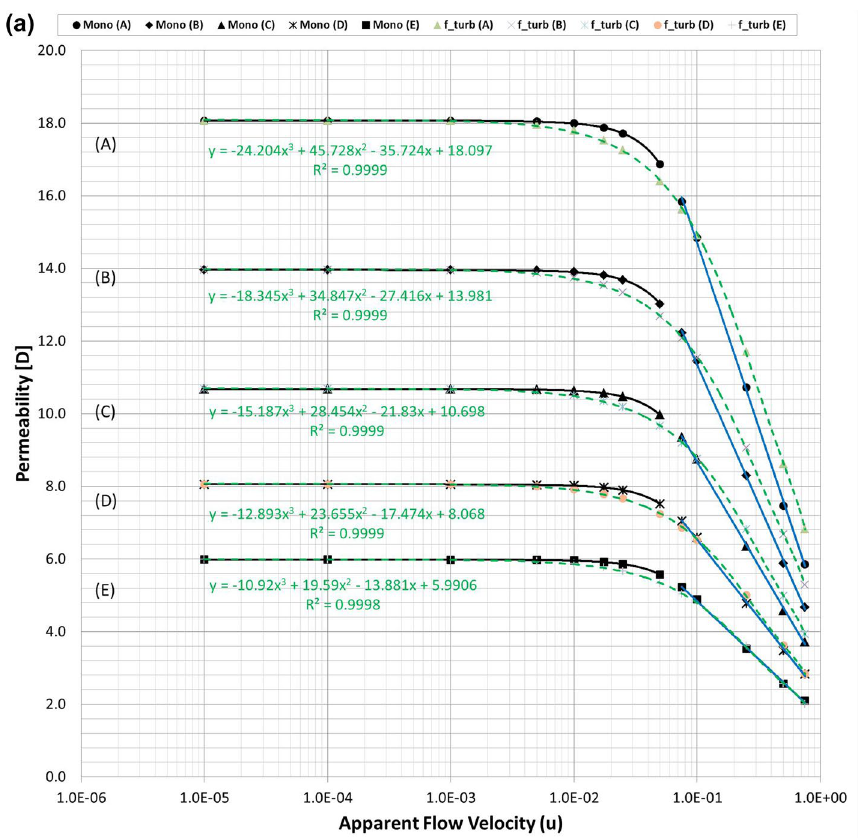
Figure 6. (a) Permeability variations of the mono-size pack models were estimated using Eq. (6) (dotted pink lines) and compared with those directly obtained from each PSS analysis (solid black and blue lines) and the regression curves of the estimated permeability for each PSS case. (b) Permeability variations of the multi-size packs in the X-directional flow conditions were estimated using Eq. (6) (dotted pink lines) and regression curves for each PSS case. (c) Permeability variations of the multi-size packs in the Y-directional flow conditions were estimated using Eq. (6) (dotted pink lines) and regression curves for each PSS